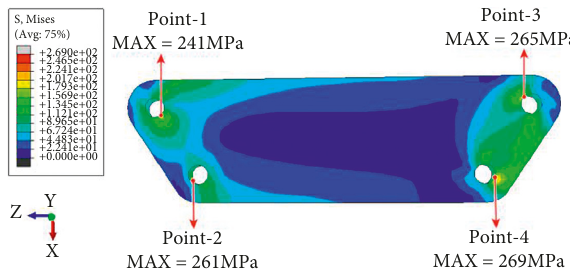
Figure 35: Stress cloud picture of trapezoidal yoke plate.